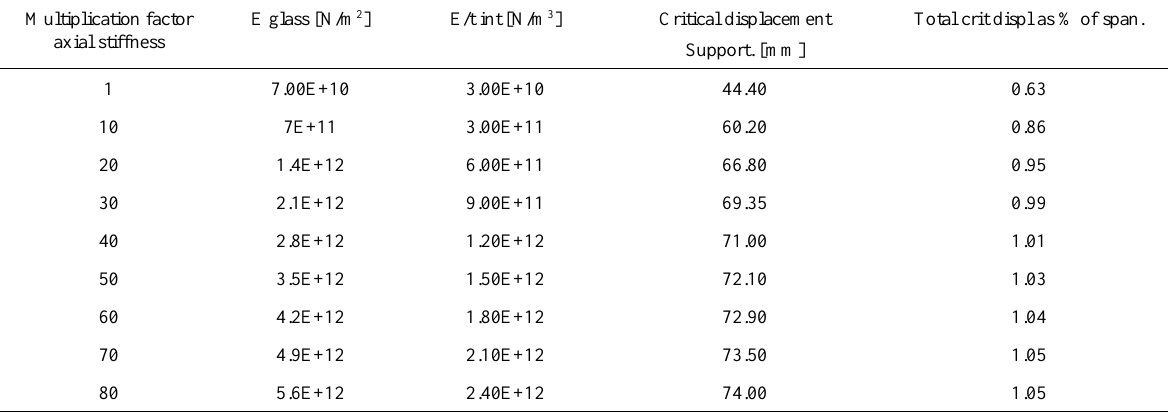
Table 3 Results increasing axial stiffness for t=400mm